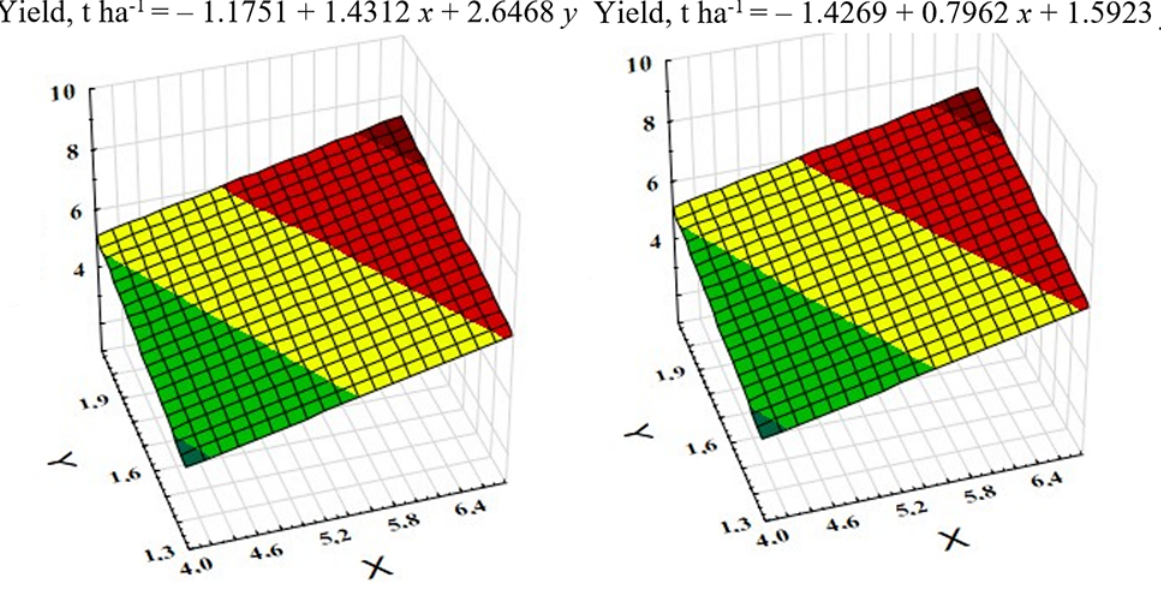
Figure 9 e graphs of the winter wheat yield depending on the elements of the yield structure under the conditions of unstable moisture for the ‘Smuhlyanka’ and ‘Slavna’ (le) and ‘Kubus’ and ‘Mulan’ (right) cultivars. Note: X – productive tillering; Y – grain weight per spike